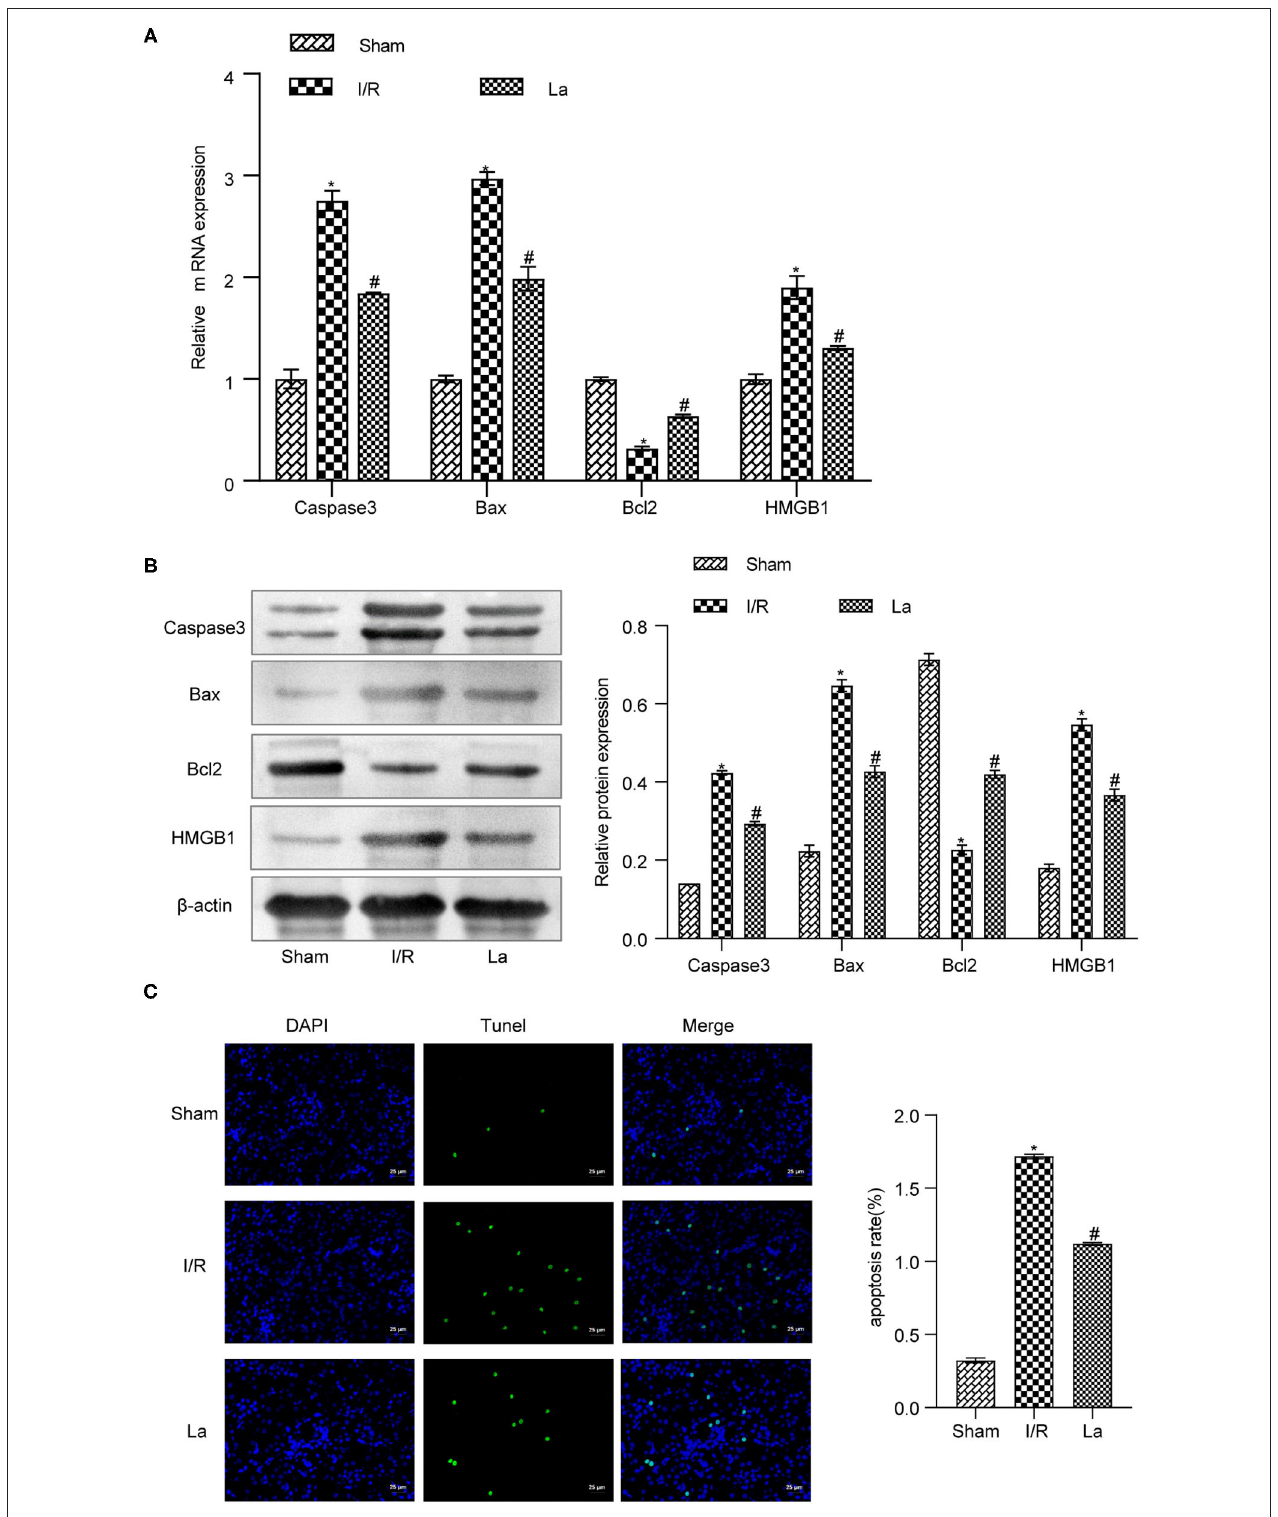
FIGURE 4 | Lactobacillus acidophilus ATCC 4356 inhibited cell apoptosis in mice with renal ischemia–reperfusion injury (IRI). (A) Relative mRNA levels of caspase 3, Bax, Bcl2, and high-mobility group box protein 1 (HMGB1) in renal tissues of each group. (B) The relative protein expression of caspase 3, Bax, Bcl2, and HMGB1 in kidney tissues of each group. (C) TdT-mediated dUTP nick end labeling (TUNEL; 400 × , scale bar = 25 µ m) to evaluate the apoptosis level of renal tissue in each group. All data are expressed as mean ± standard deviation. All experiments were repeated three times independently. Statistical significance was calculated using one-way analysis of variance. * p < 0.05 vs. Sham, # p < 0.05 vs. I/R.